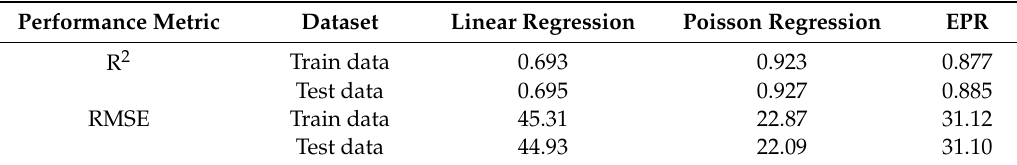
Table 5. Comparison of model